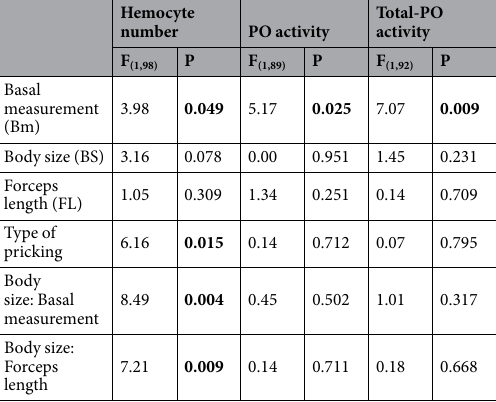
Table 1. Effects of basal immunity, body size, forceps length, type of pricking (control versus LPS), and their interaction on the hemocyte concentration, PO, and total-PO activities after the injections of LPS or control solutions. The basal immunity corresponds to the value of each immune parameter measured 24 h before the pricking. Significant P-values are in bold. These three models first included all possible interactions between the explanatory factors and were then simplified (see